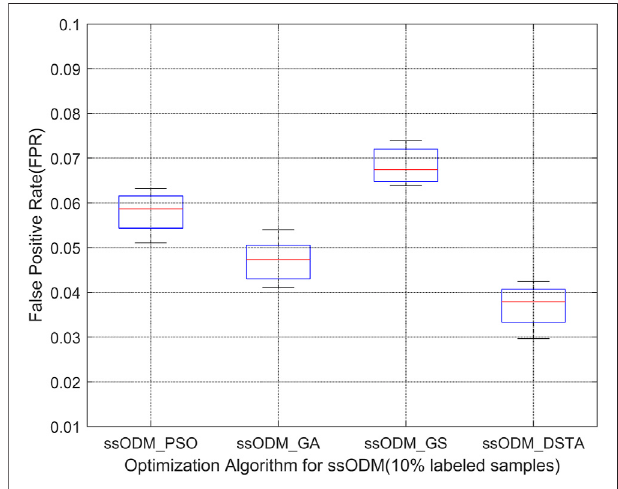
FIGURE 9 | Boxplot of FPR of CAN communication fault detection regarding blade 1 servo driver (10% labeled samples).